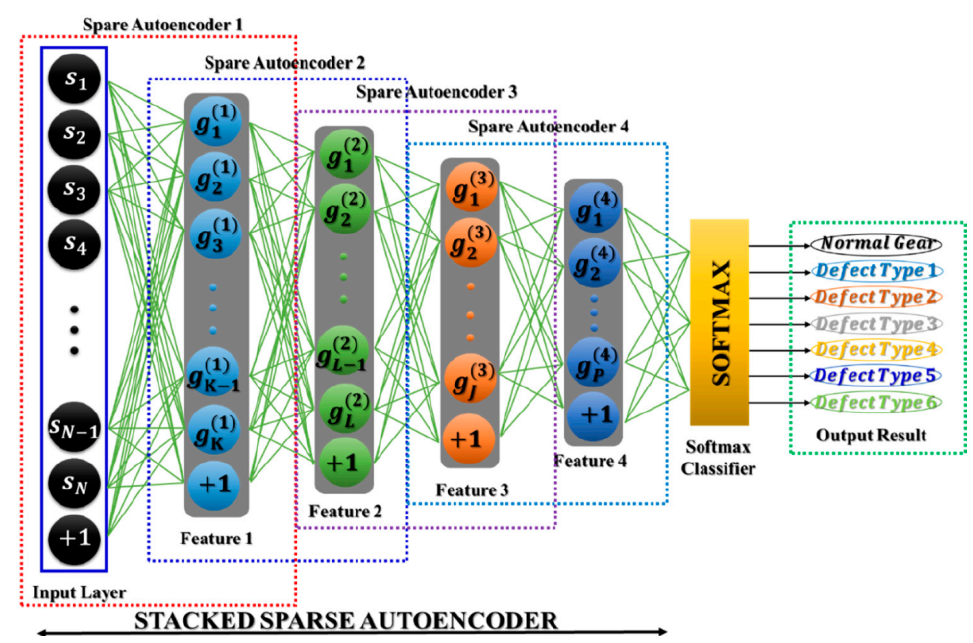
Figure 8. The DNA of a Stacked Sparse Autoencoder.